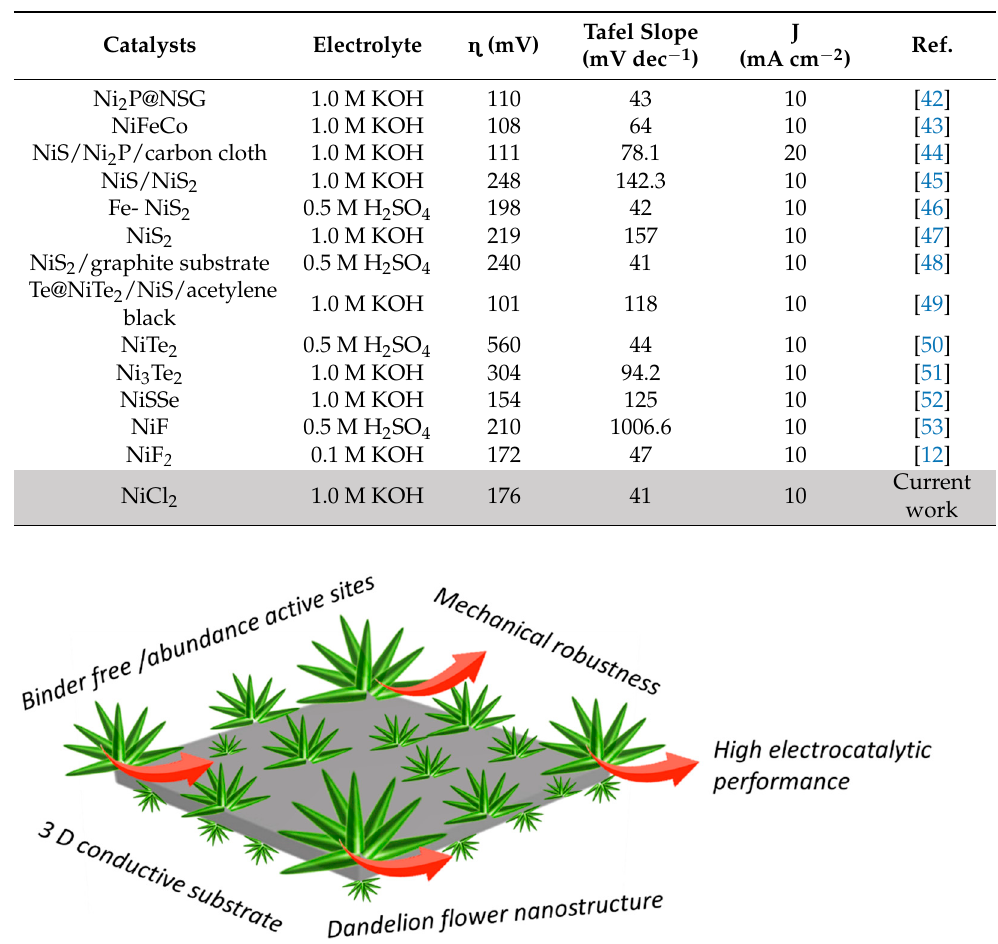
Scheme 2. Schematic presentation showing various causes responsible for the enhanced catalytic performance of dandelion flower-type NiCl 2 catalyst towards the HER. Table 1. The comparative set up showing HER activities of present work with reported data. Catalysts Electrolyte